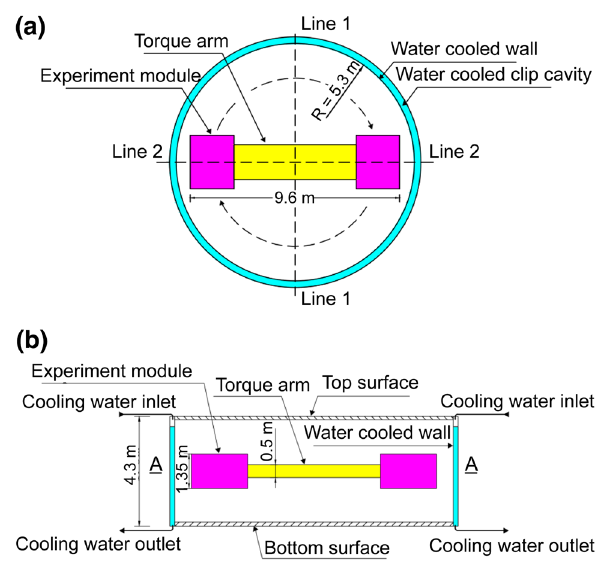
Fig. 2 Schematic diagram showing the a top and b side views of the computational fluid dynamics (CFD)